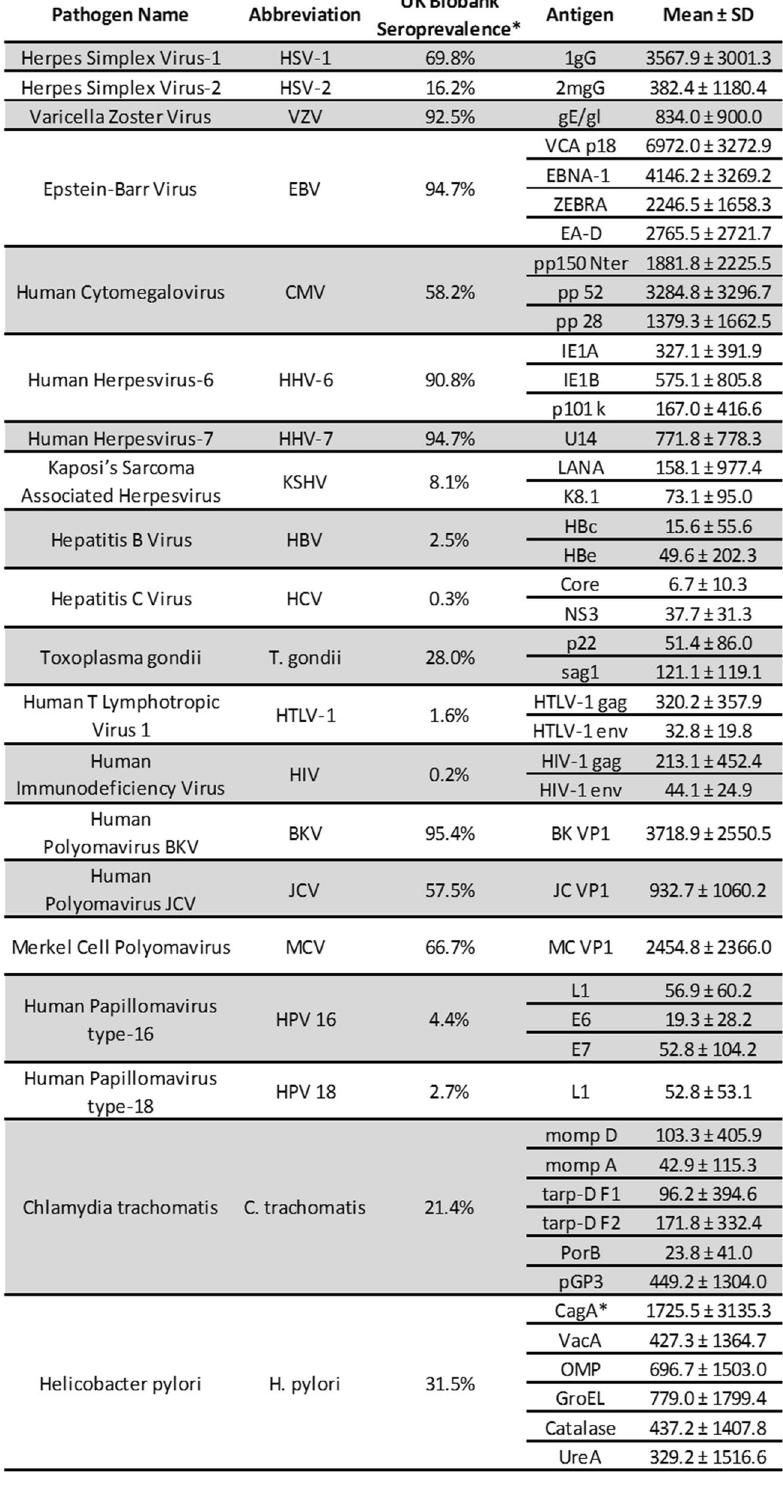
Table 2. Baseline characteristics of infectious disease serology from 2006 to 2010. Antibody levels are specific to each antigen and expressed in Median Fluorescence Intensity (MFI) units. Seroprevalence of at least the main UK Biobank cohort was estimated on samples from 9695 randomized participants, as described in white papers (see “Methods”). The “bold” and “italics” shading are used to distinguish between pathogens and their respective antigens. a CagA levels are based on roughly half of the original sample due to a technical lab